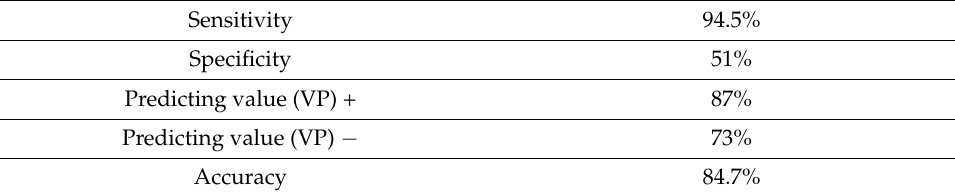
Table 3. Diagnostic